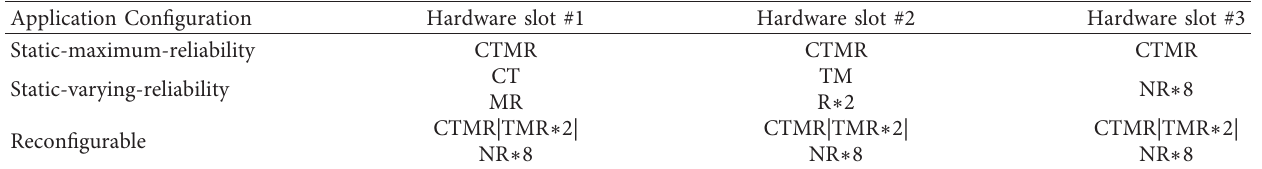
Table 3: Hardware slot